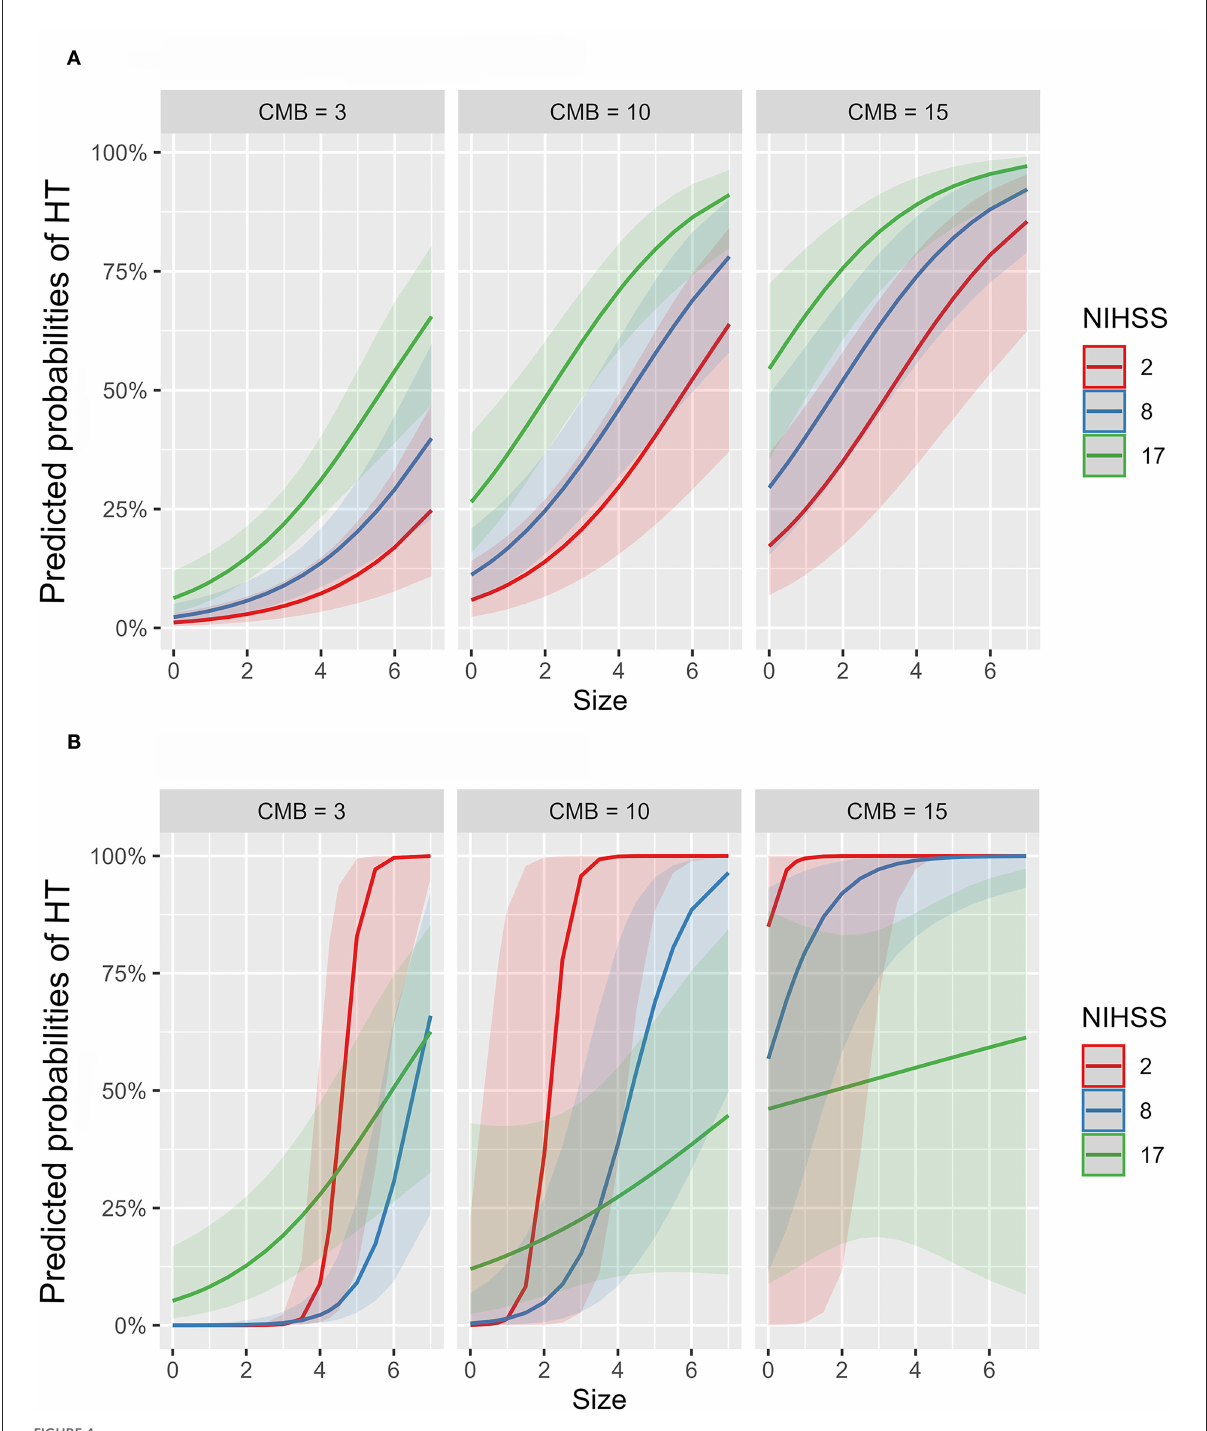
FIGURE4 Partial probability of HT incidence as a function of infarction size and conditioned on NIHSS score and CMB count. (A,B) show logistic regression fitted with single terms and a generalized additive model fitted with thin plate regression splines with tensor product terms, respectively. Tensor product terms could delineate the interaction component from the main effect. (A) shows monotonous NIHSS curves that demonstrate similar parametric functions with infarction size at different CMB levels except for an absolute effect representing different intercepts. This logistic regression pattern suggests a failure to detect predictor interaction and hence predictive power. In contrast, (B) demonstrates non-linear HT predicting functions as reflected by NIHSS curves across different levels of CMB and infarction size. For example, at a CMB level of 3, patients with a low NIHSS score of 2 started to respond at an infarction size of around 3.5 and exhibited sharp dependency on infarction size in contrast to patients with an NIHSS of 17, which started to respond at an infarction size of zero but with less dependency on infarction size. At CMB 15, the curve of the NIHSS score of 2 almost reached saturation, whereas the curve of the NIHSS score of 17 almost becomes linear with a low slope demonstrating less dependency on infarction